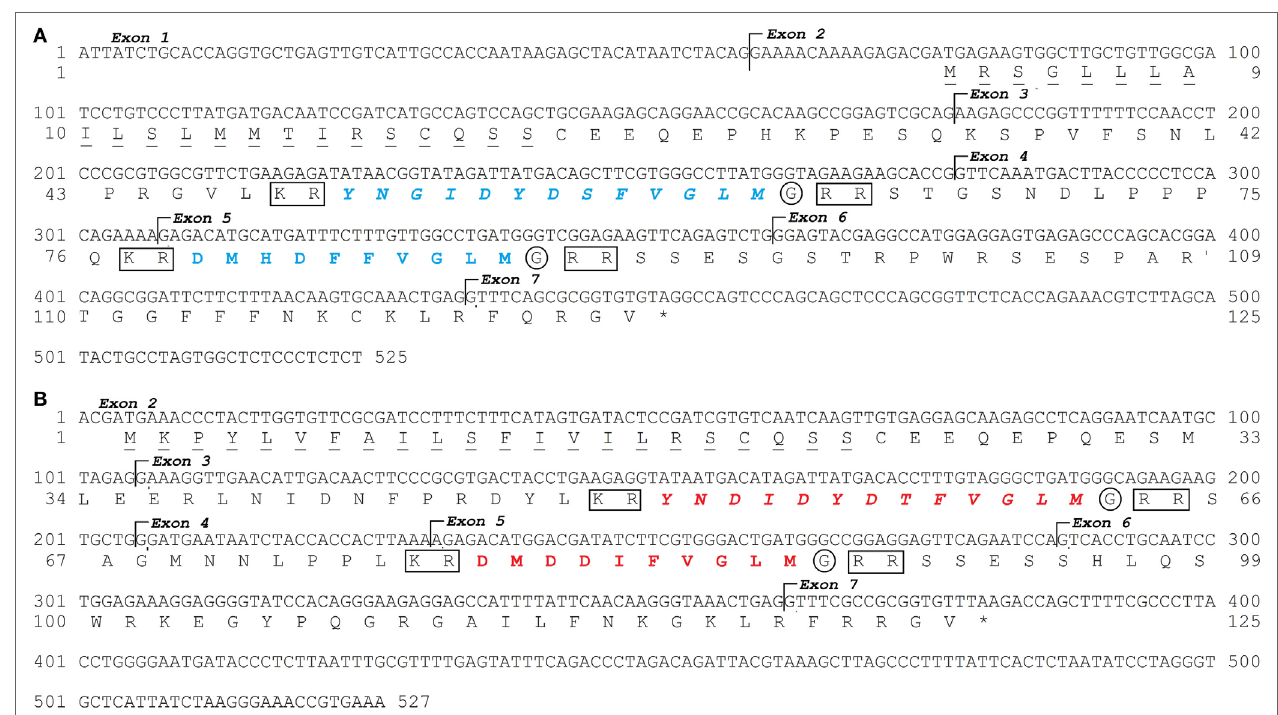
FigUre 1 | European eel tac3a and tac3b sequences. Nucleotide and deduced amino acid sequences of tac3a (a) and tac3b (B) . Nucleotides (top) are numbered from 5 ′ to 3 ′ . The amino acid residues (bottom) are numbered beginning with the first methionine residue in the ORF. The asterisk (*) indicates the stop codon. The seven exons are indicated. The amino acids of the signal peptide are underlined. The TAC3 peptides encoded by tac3a are in blue and by tac3b in red. Related peptides are in italic. The cleavage sites are marked by a square and amidation sites by a